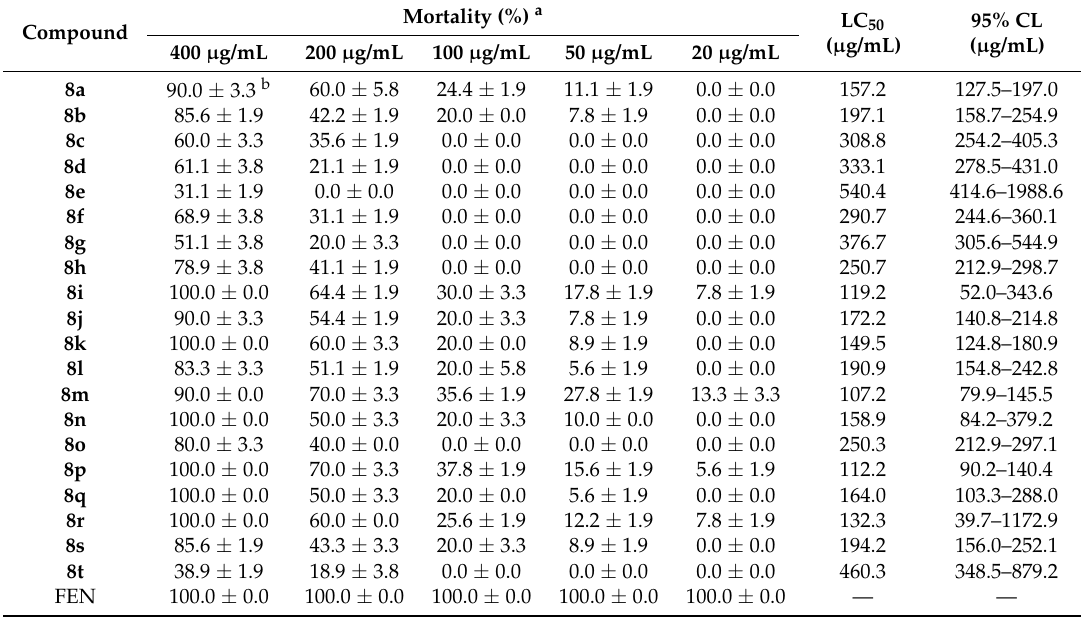
a Experimental size: 30 insects per group, three groups. b Each value represents the mean ± standard deviation of three replications; LC 50 = 50% lethal concentration; 95% CL = 95% confidence limit; “—” refers to “not